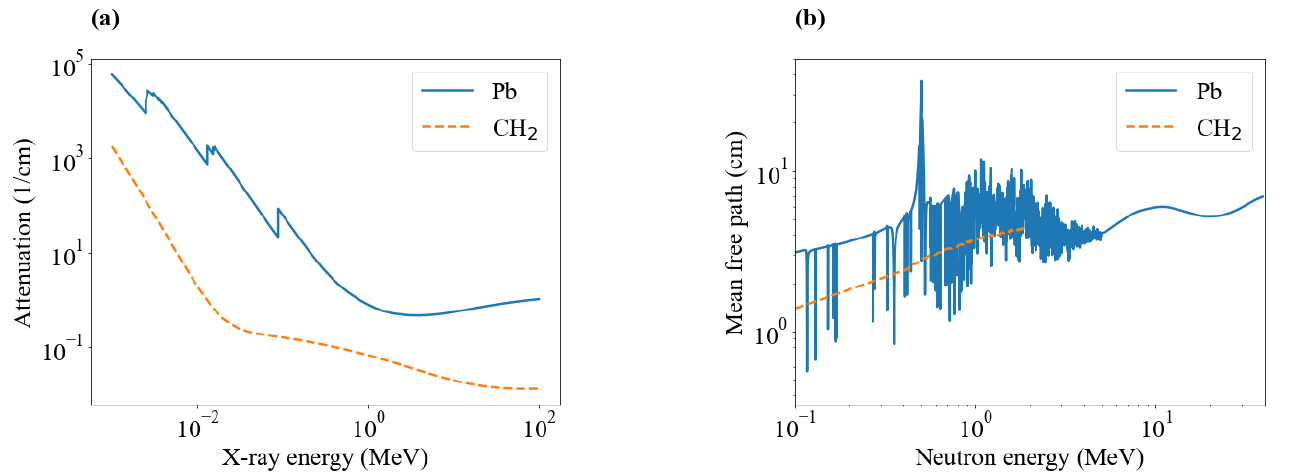
Figure 6. The raw nTOF detector trace recorded for a pitcher–catcher configuration located 7.2 m away with 27 cm lead shielding in front of the nTOF shows a gamma peak component followed by the neutron signal.